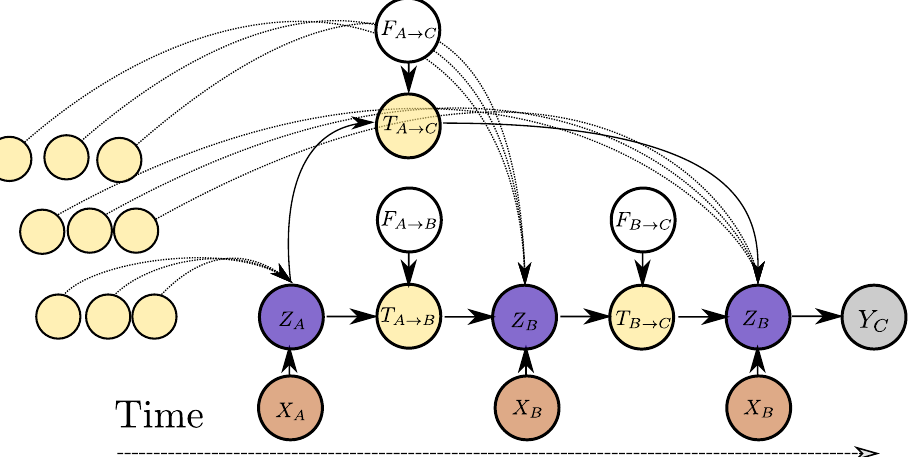
Figure 5. Dependency graph for the variables associated with the proposed model. X A represents the raw observed variable at time t A . Variable Z A represents the (unobserved) state that can be translated to the quantity of interest Y C or a probabilistic